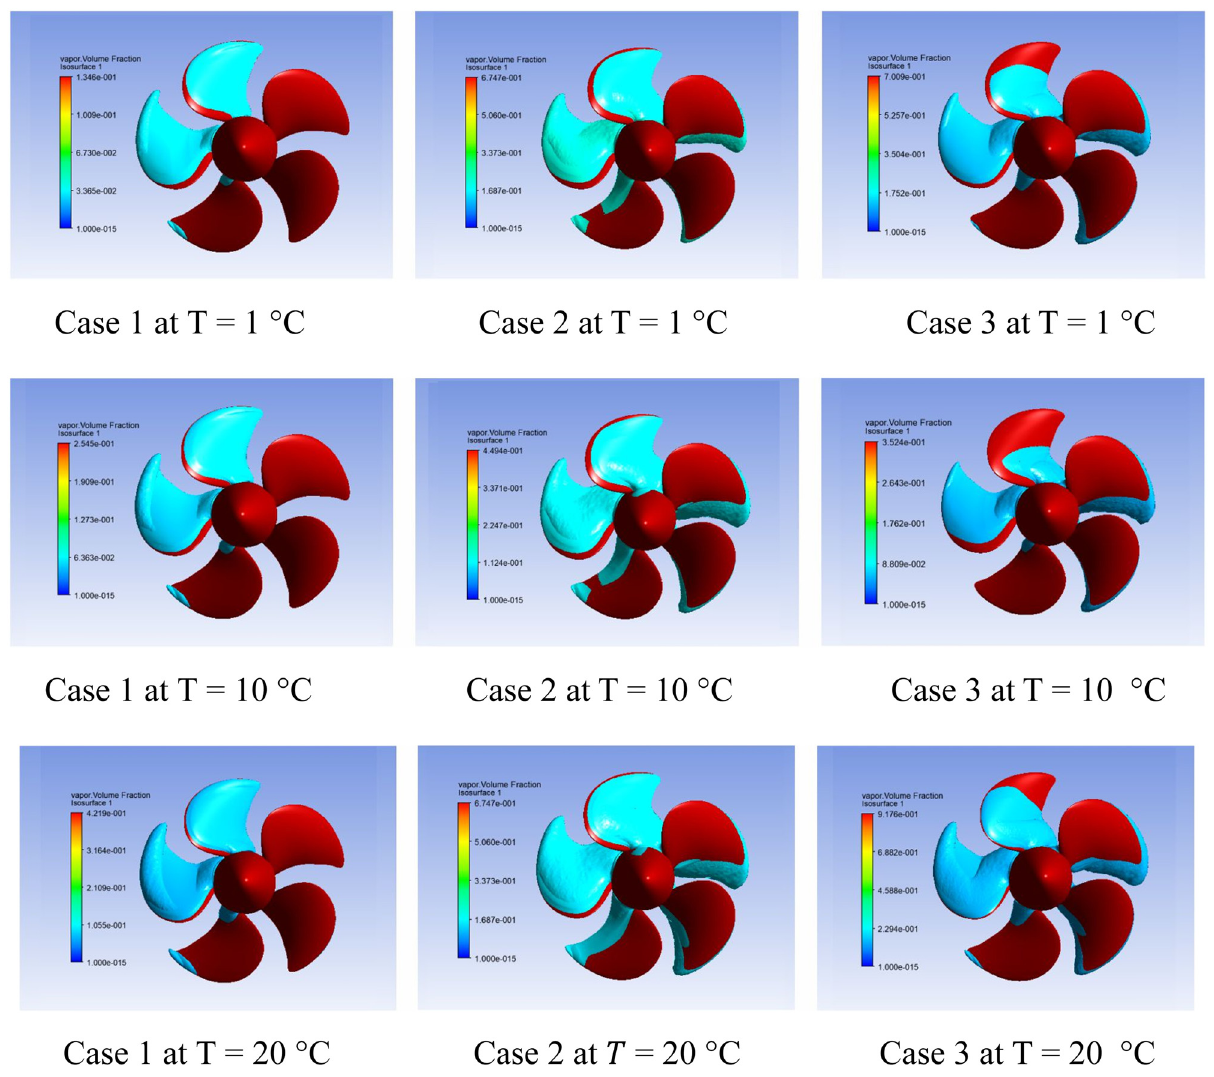
Figure 19: Isosurface cavitation of the suction side for three di ff erent cases and conditions. Results are obtained at a vapor volume fraction of